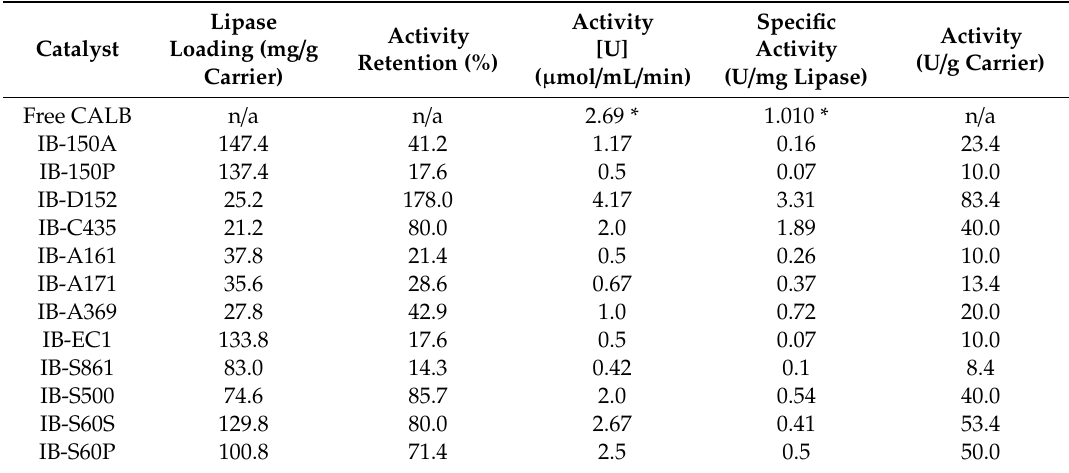
Table 6. The results of the CALB immobilization